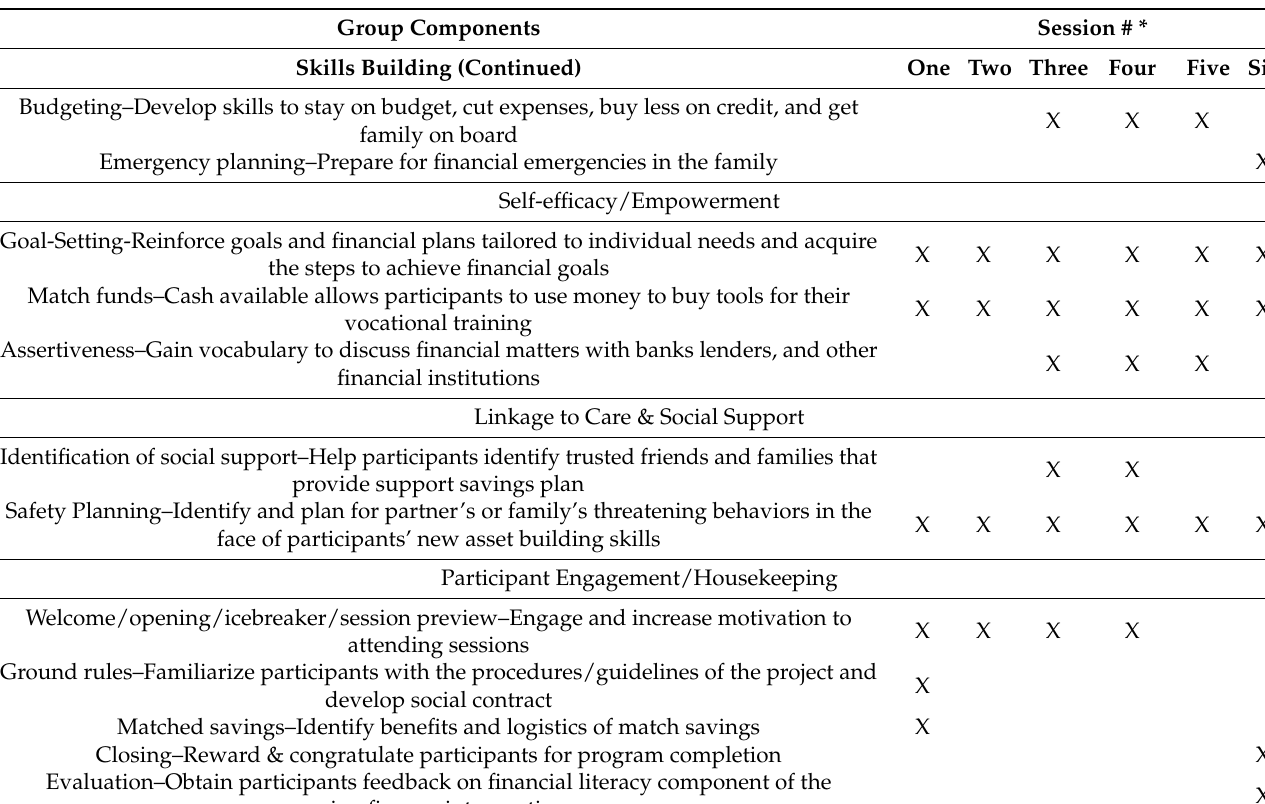
Table 4. Group components integrated into financial training sessions